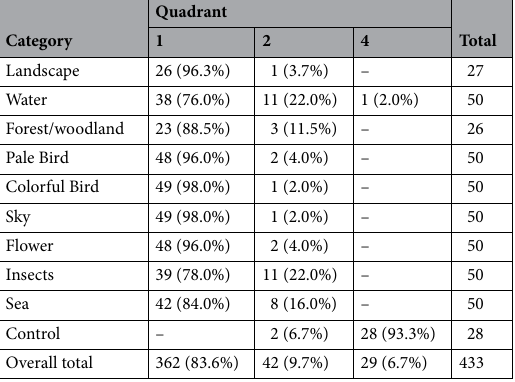
Table 2. Distribution of nature pictures per quadrant by image category.